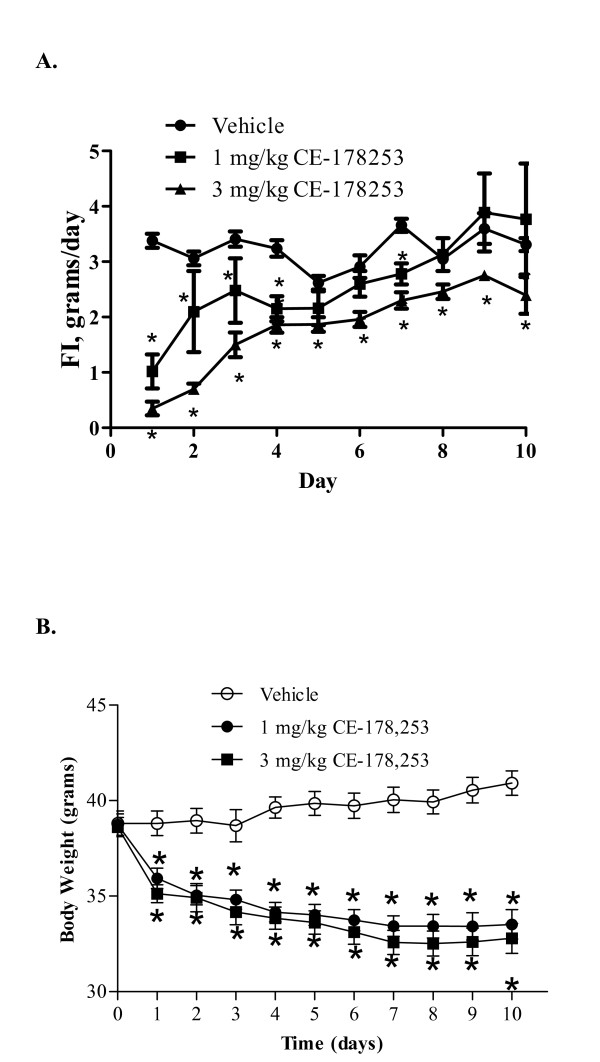
Effect of CE-178253 on FI (8A) and BW (8B) in DIO mice. FI and BW were measured in DIO mice (baseline body weight = 38.8 ± 0.7 g (Veh.), 38.7 ± 0.6 (1 mg/kg CE-178253) 38.8 ± 0.6 (3 mg/kg CE-178253); mean ± SEM, n = 10/group) daily after once daily administration of veh. (0.5% MC) or CE-178253 at either 1 mg/kg or 3 mg/kg p.o. FI data shown are the total amount of food consumed expressed in grams consumed for each day of treatment. The mean ± SEM (n = 10/group) is shown. * = p < 0.05 vs. veh.